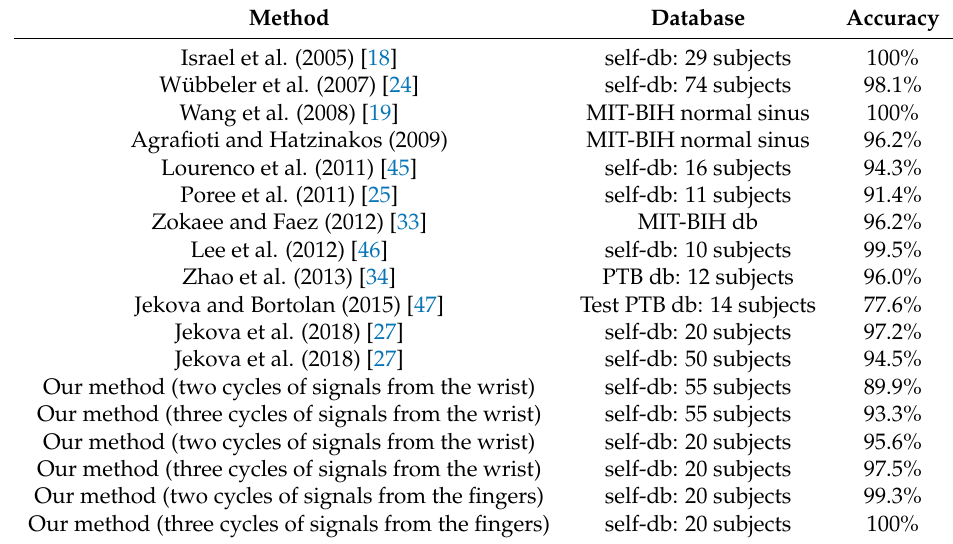
Table 5. Comparison between the proposed method and other approaches.